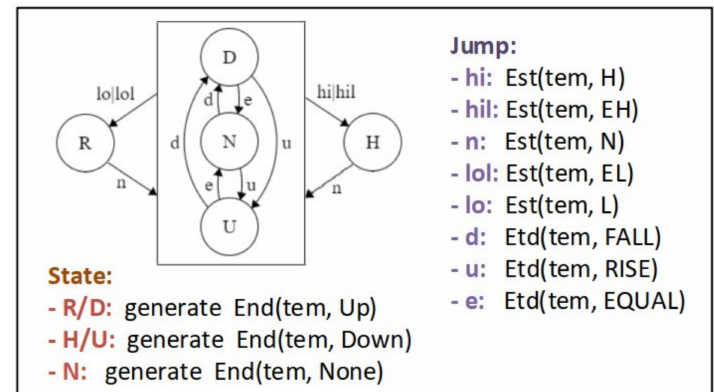
Figure 10. EPA 7.